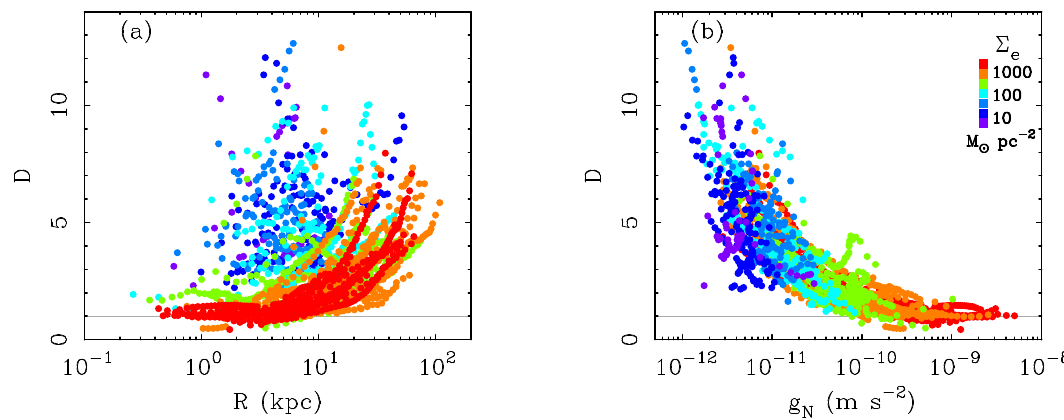
Figure 2. The amplitude of the acceleration discrepancy D = a / g N of galaxies in the SPARC database [29] as a function of ( a ) radius and ( b ) the expected acceleration. Each point is an accurate ( σ V / V < 5%), resolved measurement, with multiple measurements per galaxy. The centripetal acceleration a = V 2 / R is measured from rotation curves while that predicted for the observed baryons g N is computed by solving the Poisson equation for the observed distribution of stars and gas. Points are color coded by the effective stellar surface densities of their galaxies (legend), as in Figure 1. The need for dark matter ( D > 1) appears gradually at large radii in high surface brightness (HSB) galaxies but is greater and sets in at smaller radii in galaxies of progressively lower surface brightness ( a ). This behavior was anticipated by MOND [16], along with the correlation of the amplitude of the discrepancy with acceleration ( b